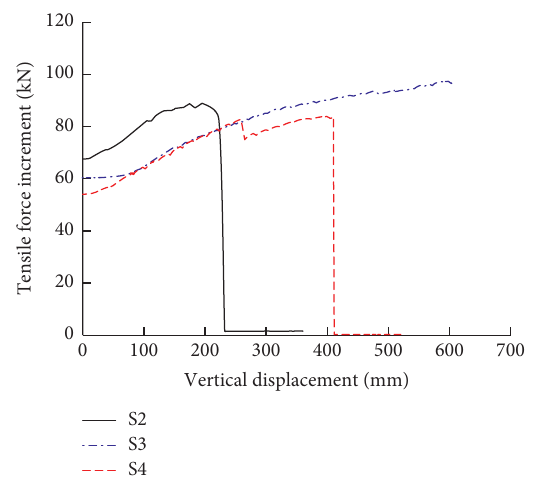
Figure 9: Relationship between tensile force increment and vertical